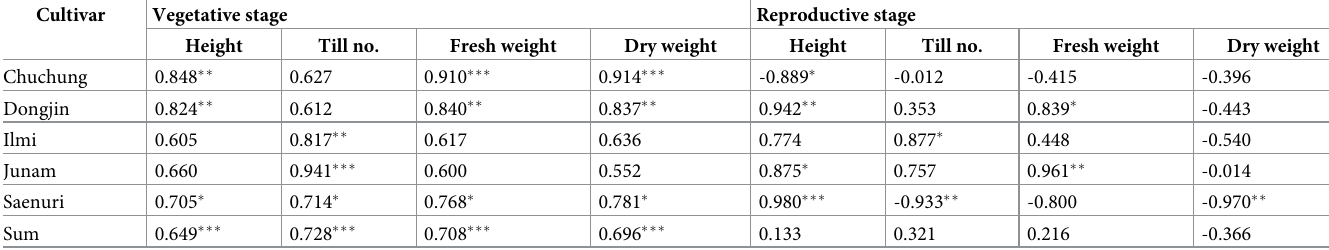
Table 2. Correlation coefficient between CH 4 emission rates and rice growth characteristics at vegetative and reproductive stage.